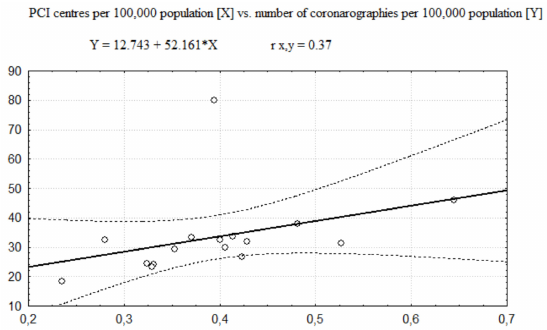
Figure 3. The regression function of PCI centres per 100,000 population vs. number of coronographies per 100,000 population.